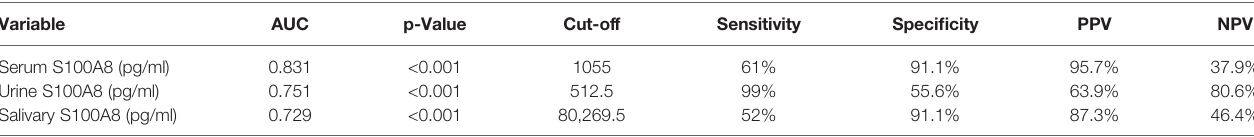
TABLE 2 | Utility of S100A8 levels in serum, urine, and saliva for diagnosing SLE. Variable